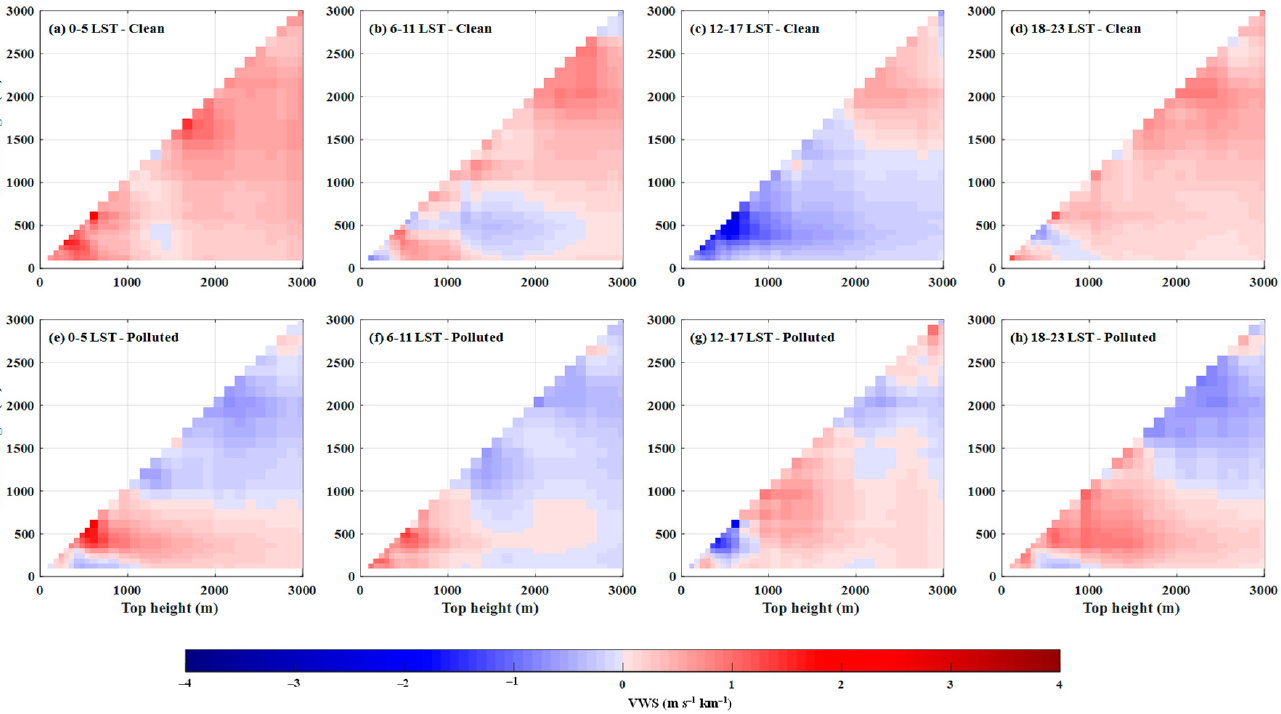
Figure 6. Anomalies of 6 hourly averaged VWS computed between different heights relative to averages of winters from 2016–2020 under ( a – d ) clean and ( e – h ) polluted conditions in CS for ( a , e ) 00:00–05:00 LST, ( b , f ) 06:00–11:00 LST, ( c , g ) 12:00–17:00 LST, and ( d , h ) 18:00–23:00 LST.